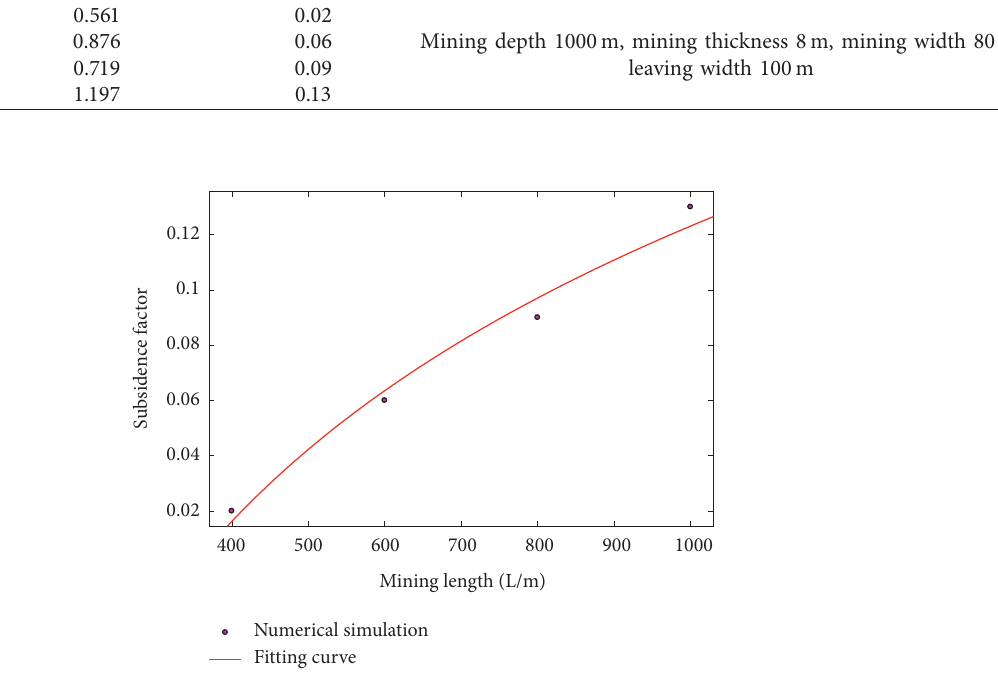
Figure 6: Relationship between the subsidence factor and the mining length. Table 5: Numerical stimulation results in different mining